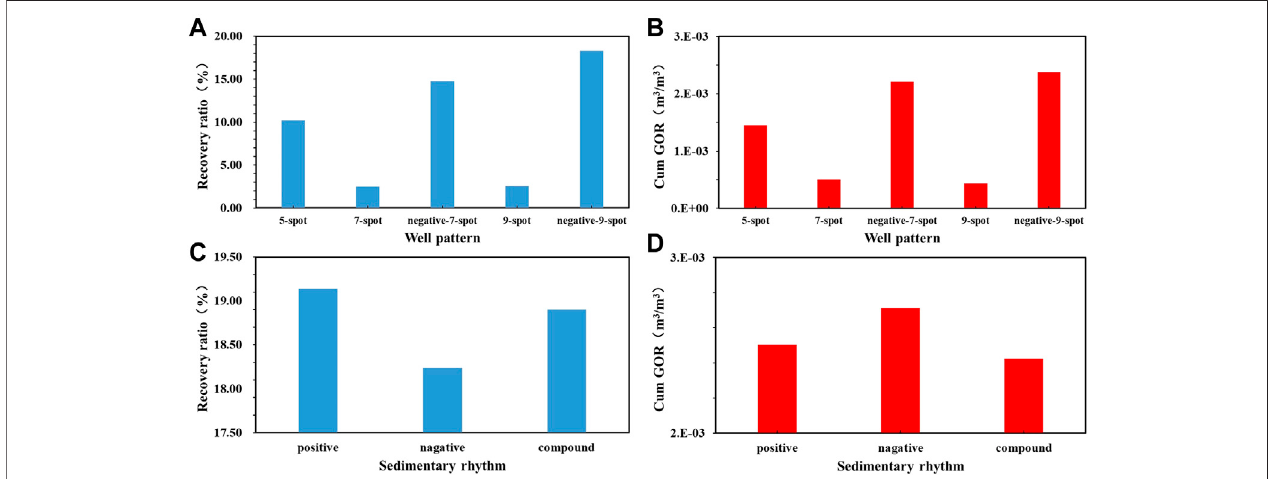
FIGURE 5 | (A) Effect of well pattern on recovery ratio; (B) effect of well pattern on cumulative gas – oil ratio; (C) effect of sedimentary rhythm on recovery ratio; (D) effect of sedimentary rhythm on cumulative gas – oil ratio.